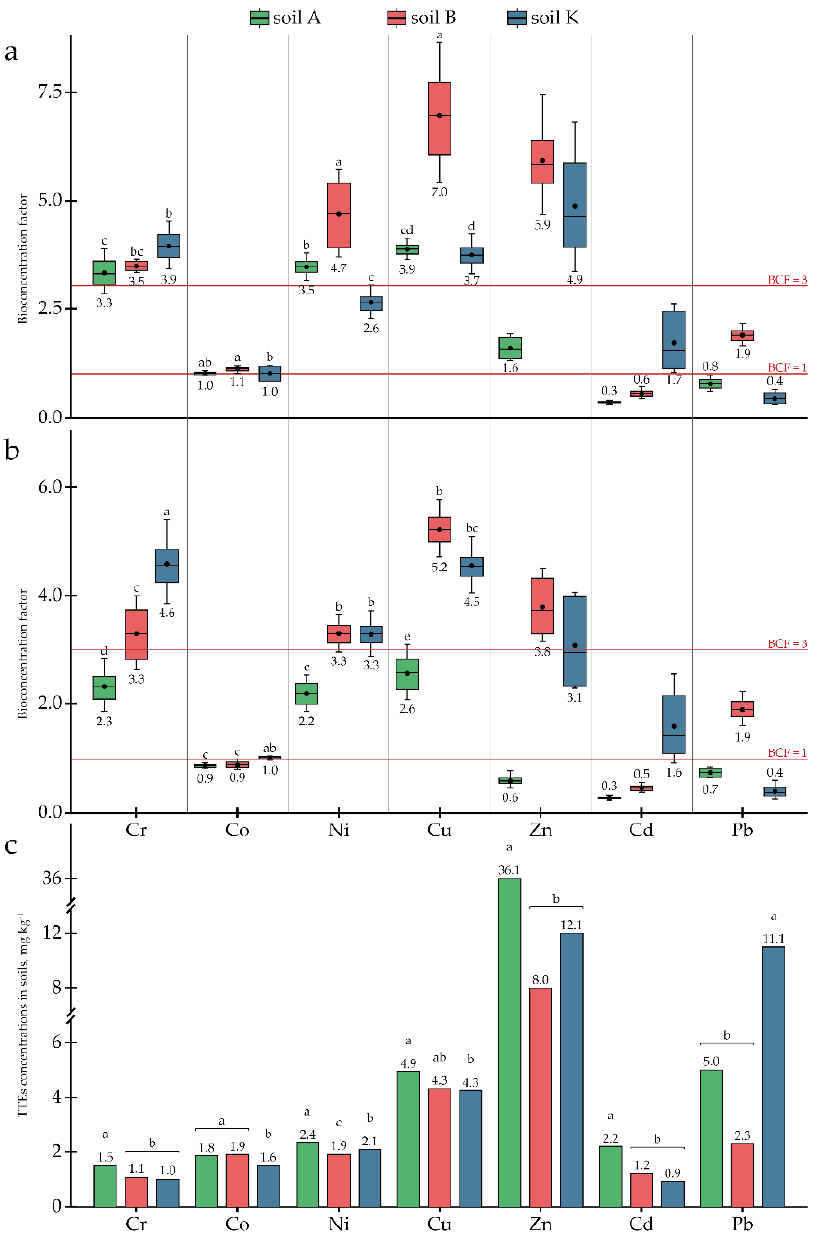
Figure 3. Bioconcentration factors for TTEs in plant parts: ( a ) AGB; ( b ) roots; ( c ) TTE concentrations in the research soils Different letters on the bar and boxplots within one element indicate a significant difference at p < 0.05.